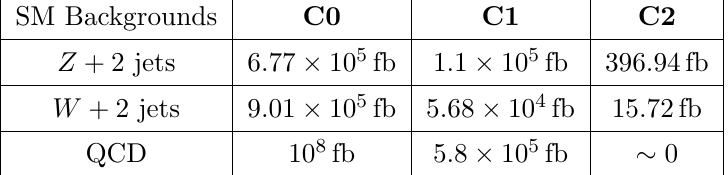
Table 3 . Cross-sections for SM backgrounds after subsequent implementation of the cuts at 13 TeV.